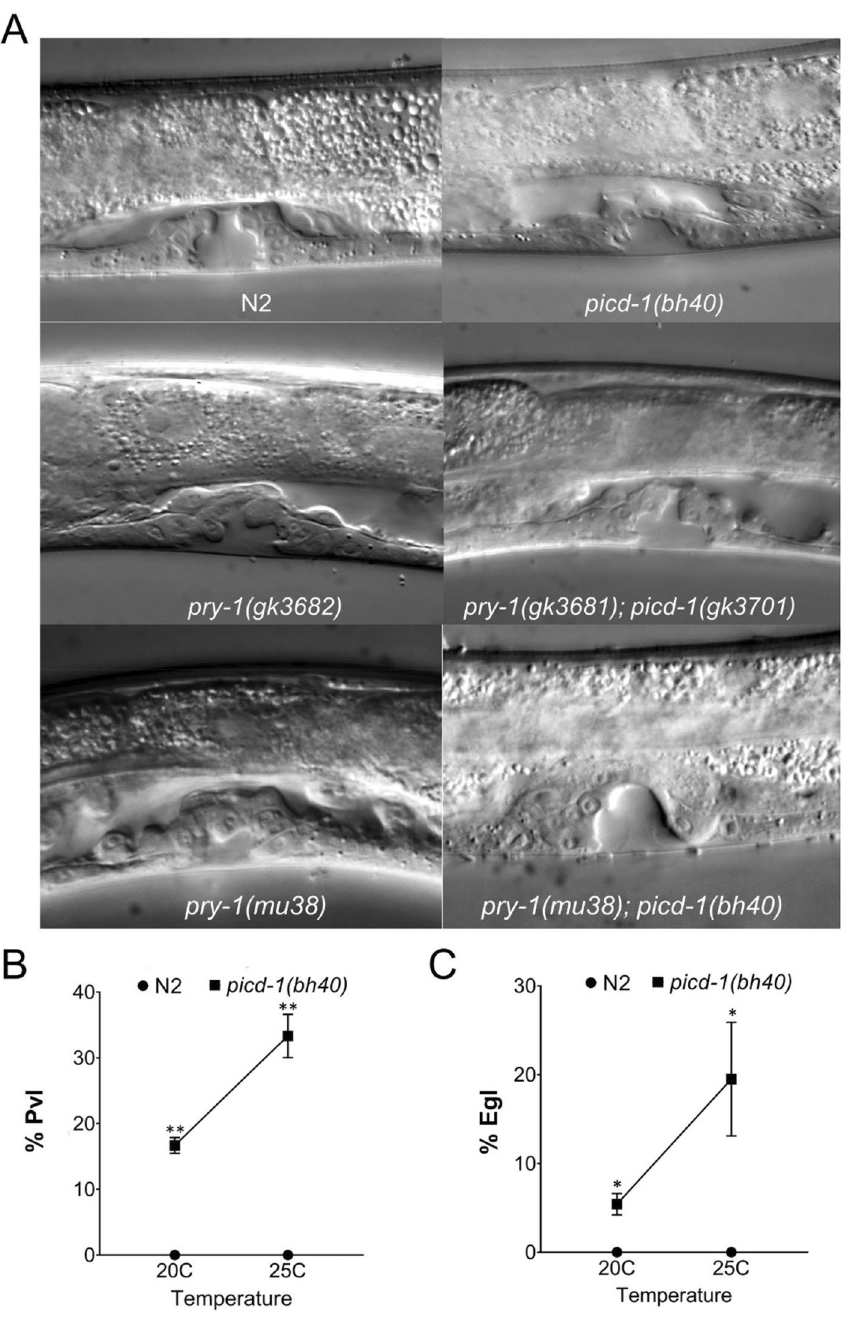
Figure 3. picd-1 regulates vulval morphology. ( A ) Representative vulval images of wild-type, and picd-1 and pry-1 mutants at the mid-L4 stage. picd-1(bh40) animals exhibited abnormal vulva morphology (20.8 ± 5.8%, p < 0.01, n = 35) compared to N2 animals. Scale bar is 50 µm. ( B ) Line graph showing the percentage of control and picd-1(bh40) mutants showing Pvl phenotype at 20 °C and 25 °C compared to wild-type controls (Also see Table 1). ( C ) Line graph showing the percentage of control and picd-1(bh40) animals with Egl phenotype at 20 °C and 25 °C. ( B , C ) Data represent a cumulative of two replicates (n = 64 for picd-1(bh40) and 58 for N2) and error bars represent the standard deviation. Statistical analyses were done using an unpaired t-test and significant differences are indicated by stars (*): * ( p < 0.05), ** ( p <